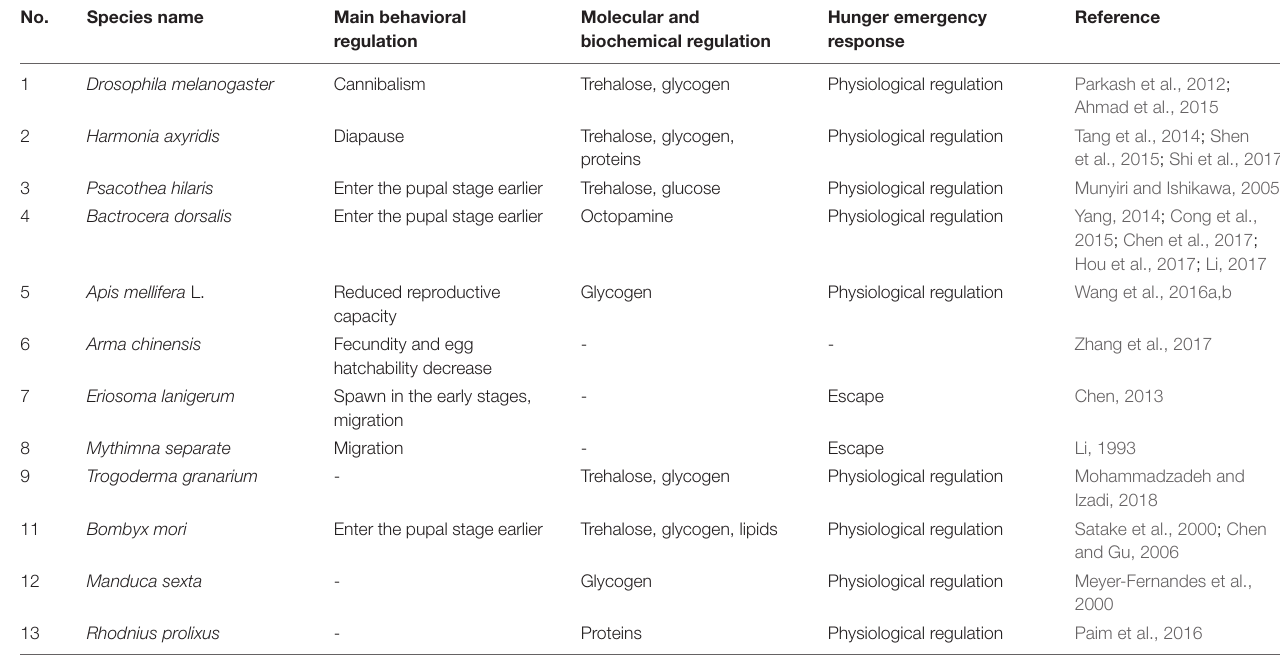
TABLE 1 | Some insect behaviors and physiological adaptions under starvation